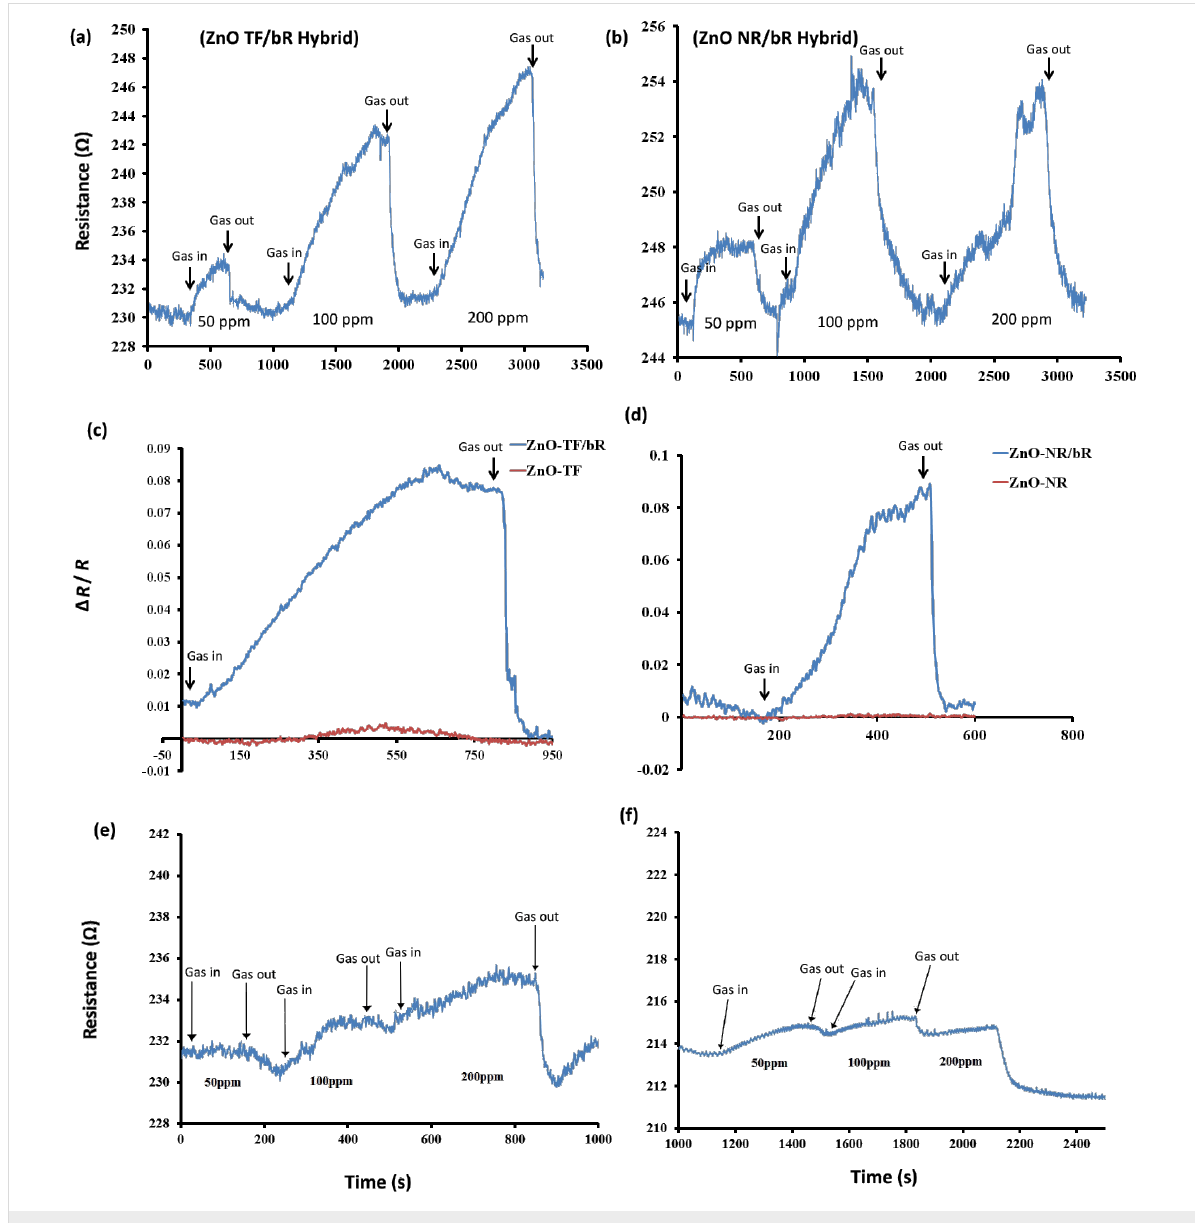
Figure 7: Dynamic response of the ethanol vapour sensing tests at 70 °C for 50, 100 and 200 ppm concentrations for (a) ZnO-TF/bR and (b) ZnO-NR/bR structures. Comparative dynamic response diagram of hybrid and nonhybrid ZnO structures at 70 °C for 100 ppm concentration for (c) ZnO-TF and ZnO-TF/bR, and (d) ZnO-NR and ZnO-NR/bR. A similar response at 65 °C for the 50, 100 and 200 ppm concentrations is shown for (e) ZnO-TF/bR and (f)